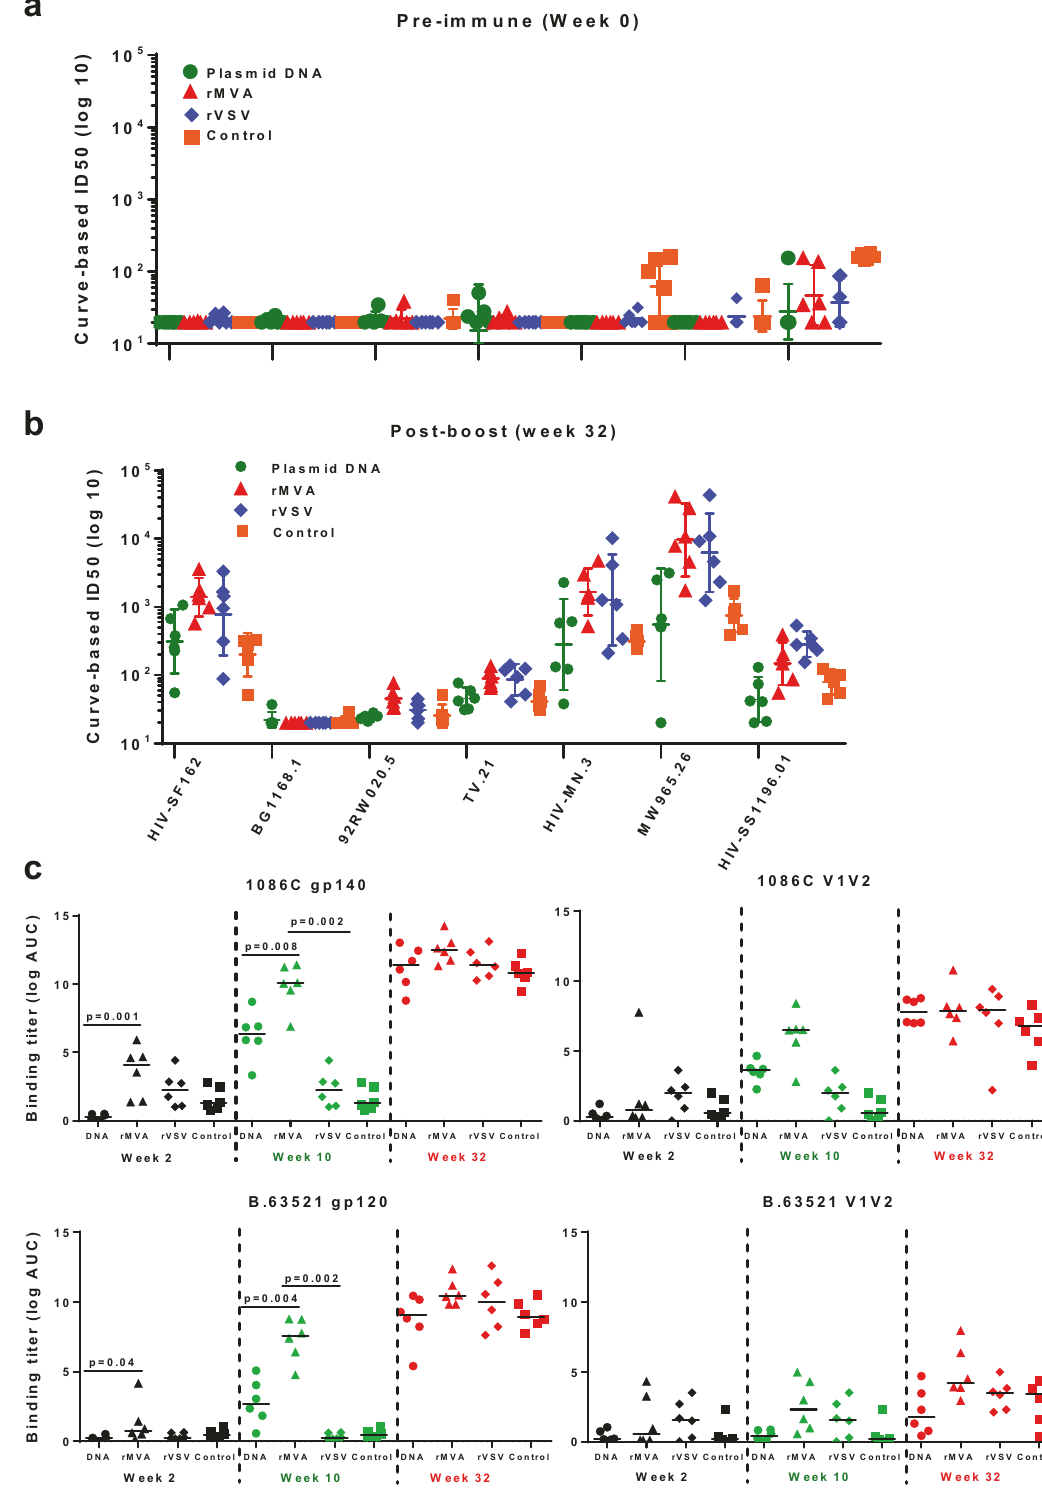
rMVA immunization provided the best neutralization titers, the gene expression of cells from rMVA group (post-boost time point) was compared with the other groups (Supplementary Table 2). Our analyses revealed an upregulation of genes such as IL-6ST, GP130, Bcl-6 and IL-4 (Tfh factors), IL-10, IL-13 (Th2), and